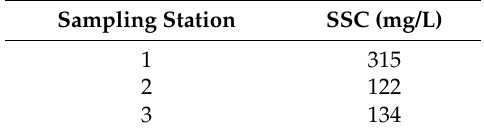
Figure 2. Locations and scopes of the different measurements. The yellow, green, and blue colors denote the land, bottom points of ALB, and bottom points of the sonar, respectively. The black triangles denote the locations of the three SSC sampling stations. The arrows denote the flight directions. In the red rectangular box, sonar sounding and ALB data compensated by the improved depth bias model are used to calculate the residual depth bias and analyze the effects of different flight directions on depth bias in Section 4. Table 2. Suspended sediment concentrations (SSC) of different sampling stations.